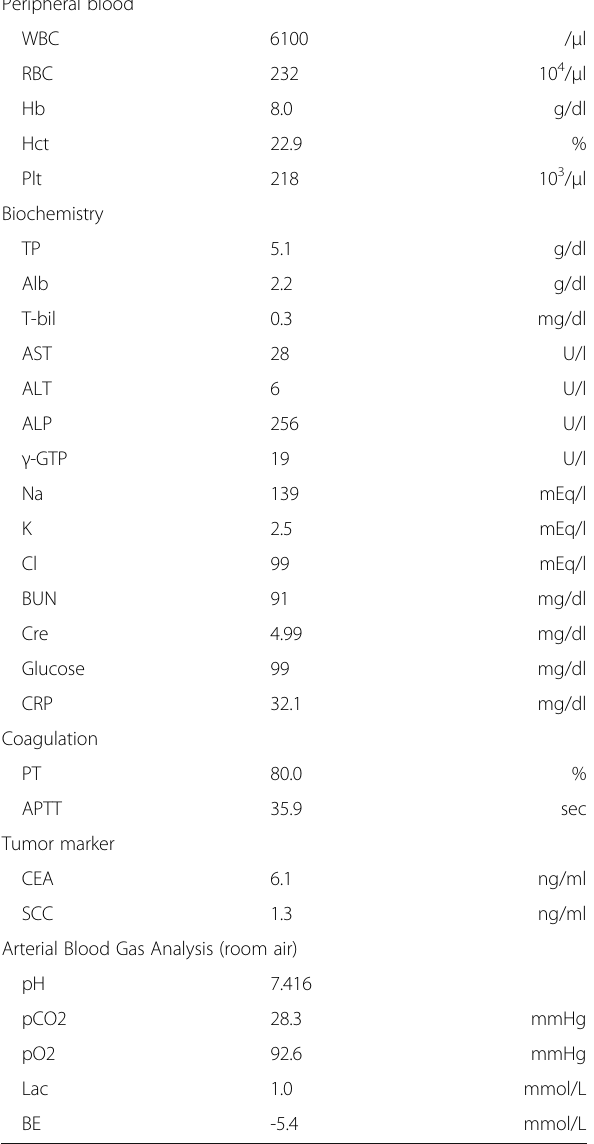
Table 1 Laboratory findings on